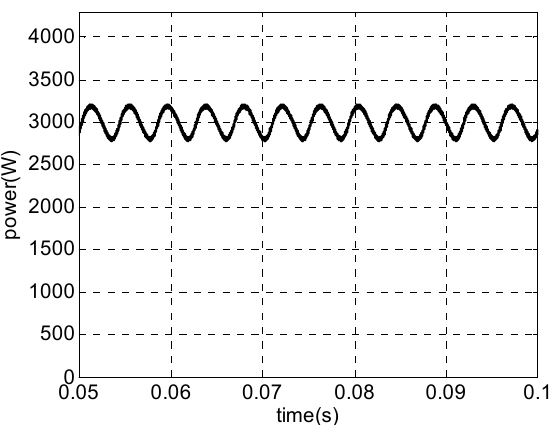
Figure 7. Generator’s active power.